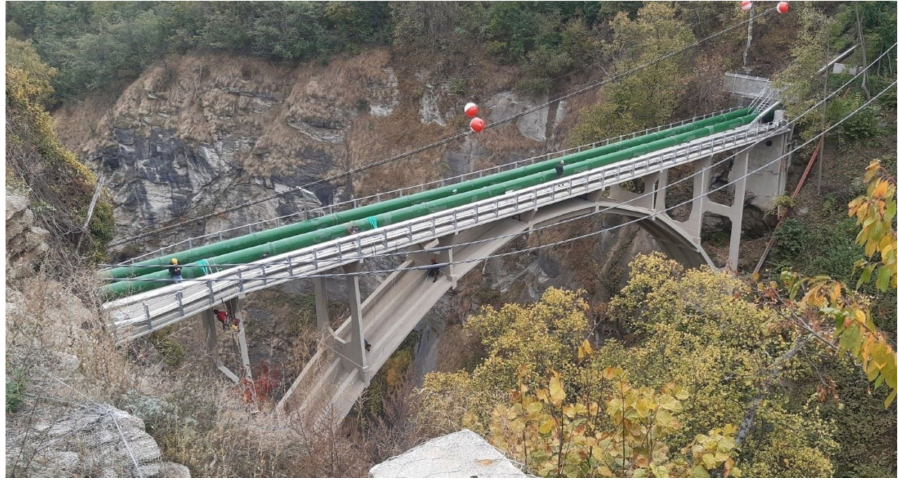
Figure 1. A view of the penstock bridge over the Dora di Rh ê mes canyon, Introd (AO),